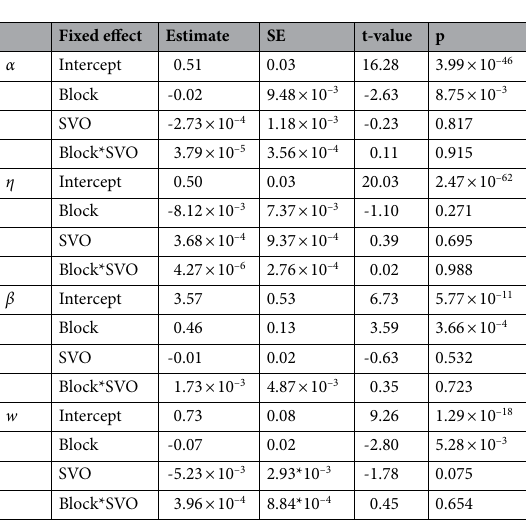
Table 2. Generalized linear mixed-effects models for parameter